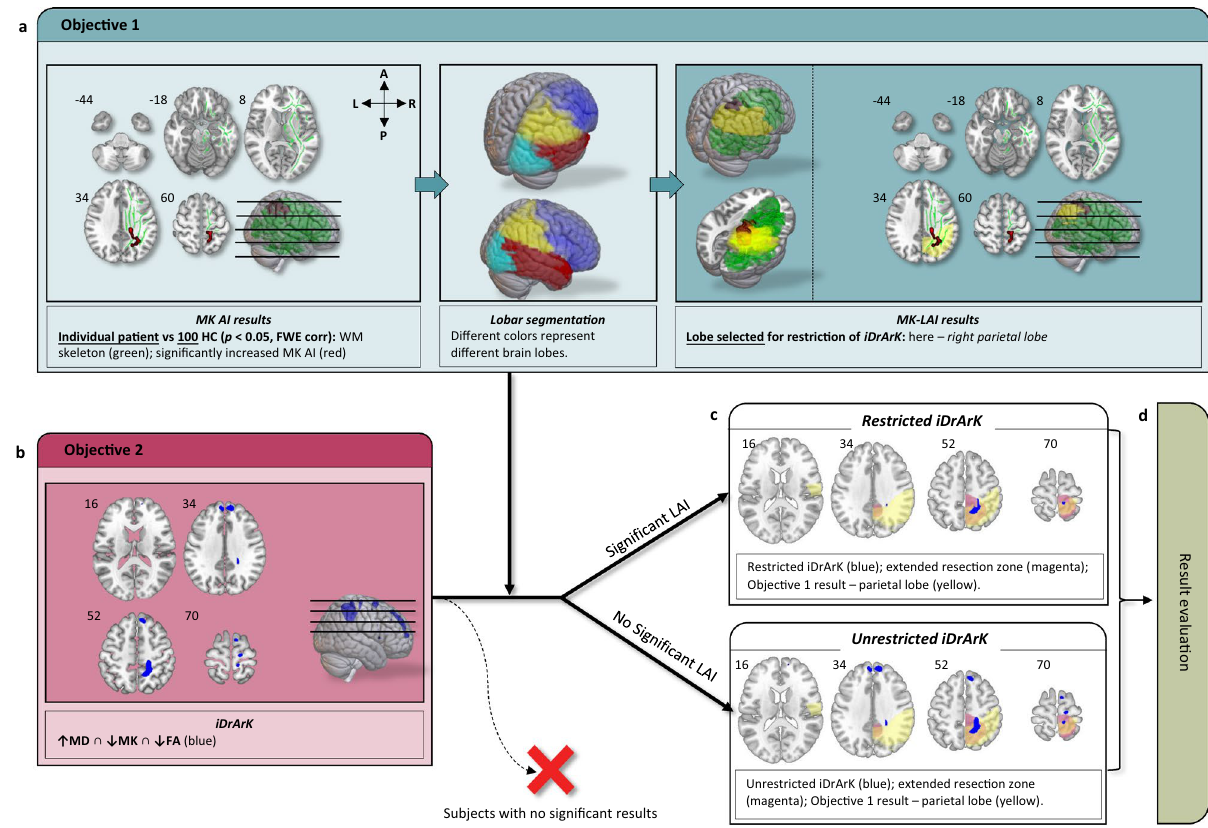
Figure 1. Data processing flowchart: ( a ): The Lobar Asymmetry Index (LAI) analysis for each patient was performed; ( b ): Combination iDrArK (increased mean Diffusivity, reduced fractional Anisotropy, reduced mean Kurtosis) maps were created by overlapping thresholded statistical parametric maps of increased MD, reduced FA, and reduced MK; ( c ): Lobe-specific restriction of iDrArK, if a significant result from the LAI analysis for a given patient was obtained; ( d ): Results were then compared to the resection zone extended by 10 mm in each direction. The red ″ X ″ represents subjects with no significant clusters in the iDrArK map (before the lobar- restriction